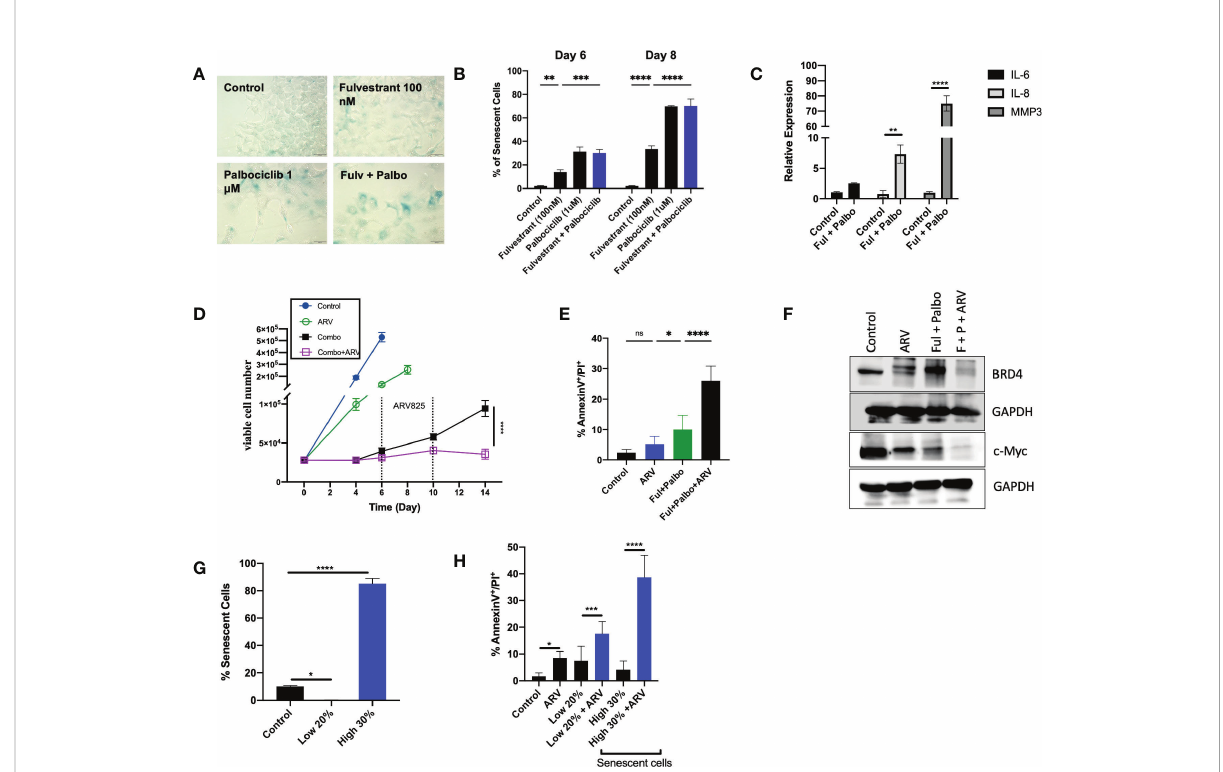
FIGURE 5 ARV prolongs growth arrest induced by Fulvestrant in combination with Palbociclib in MCF- cells. Cells were treated with Fulvestrant (100nM), Palbociclib (1uM) or the combination for 6 days. (A) Cells were fi xed on Day 6, stained with x-gal staining solution and imaged using bright fi eld microscope. All images were taken with the same magni fi cation. (B) Quanti fi cation of SA-Bgal using C12FDG at indicated timepoints. (C) qRTPCR examining SASP mRNA expression of IL-6, IL-8, and MMP3 on D6 post-combination treatment. (D) Cell viability was monitored over a period of 14 days by trypan blue exclusion. (E) Apoptosis was evaluated by fl ow cytometry using an APC Annexin V Apoptosis Detection Kit. (F) Western blotting for BRD4, c-Myc at day 4 of ARV treatment. (G) Sorted cells was analyzed by fl ow cytometry to verify purity of the SA- b -Gal positive population (high 30% and low 20% SA- b -Gal positive). Control cells were sorted for high 80% SA- b -Gal positive. (H) Sorted senescent cells were plated for 24-hours and treated with ARV-825 for 4 days followed by annexin V/PI apoptosis staining. Flow cytometry was performed post-sort for C12FDG staining to con fi rm senescence induction. *P ≤ 0.05, **P ≤ 0.01, ***P ≤ 0.001, ****P ≤ 0.0001, ns (not signi fi cant) indicate statistical signi fi cance of each condition compared to control as determined using two ‐ way ANOVA with Sidak's post hoc test. All images are representative fi elds, blots, or data from three independent experiments ( n =